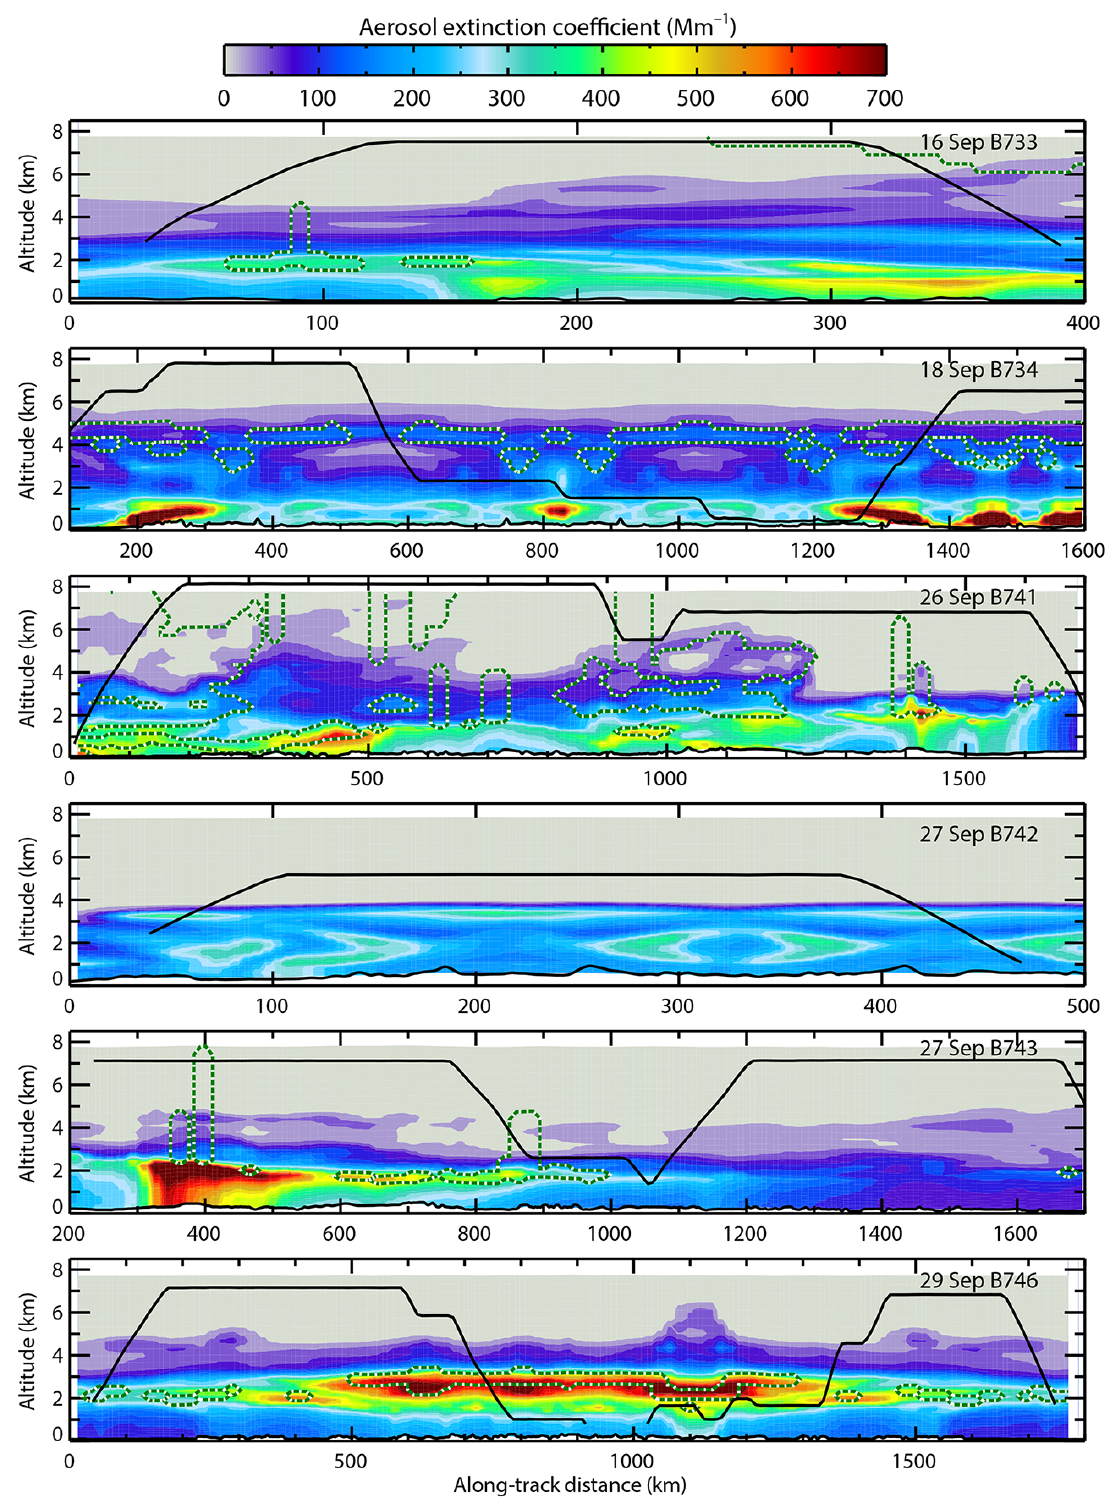
Figure 10. Cross-sections of the aerosol extinction coefficient estimated from the Met Office Unified Model (MetUM) along the tracks of the six research flights. Also shown is the position of the model clouds (green dotted